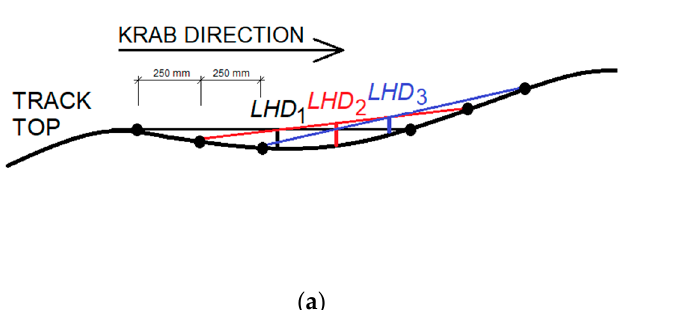
Table 2. Operating deviations AL, IL, and IAL [18] at speed of V = 160 km/h. Figure 9. Monitoring the quality of track geometry—by KRAB trolley measurements [13]: ( a ) Principle of continuous measurements of height changes LHD; ( b ) Photo [Hodas]. Parameters of Inspection